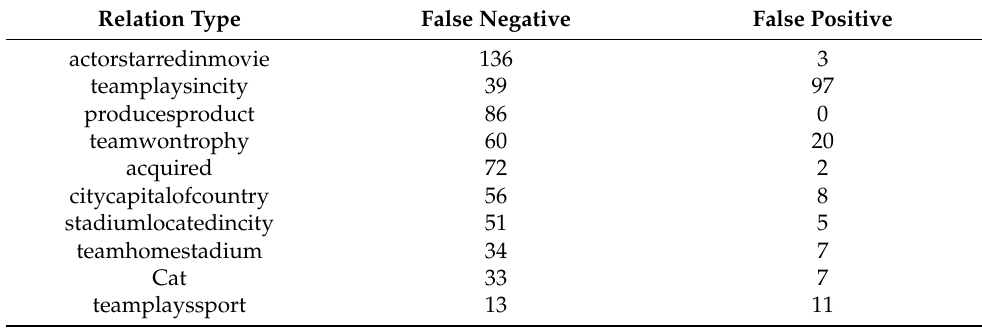
Table 5. False negative/positiverelation predictions for NELL.